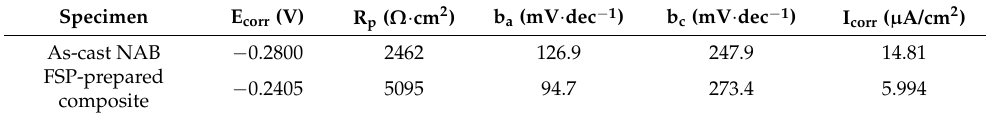
Figure 17. Potentiodynamic polarization curves for as-cast NAB and FS-processed composite in 3.5 wt.% NaCl solutions. Table 3. Potentiodynamic polarization parameters of the as-cast NAB and the prepared